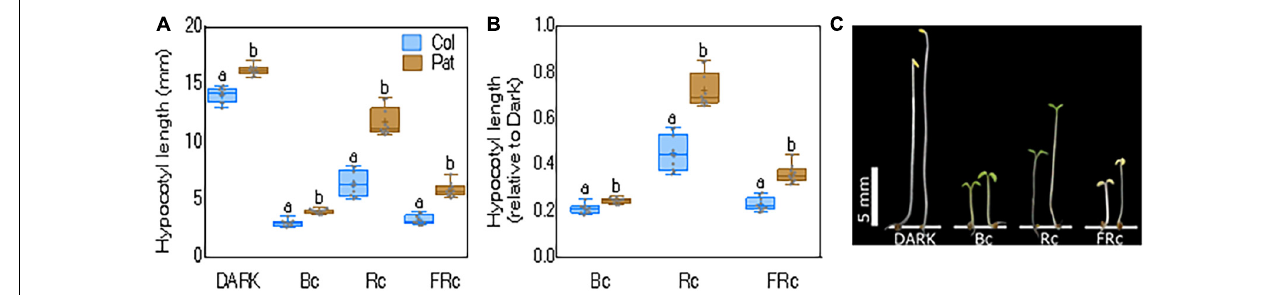
FIGURE 1 | Hypocotyl length for seedling de-etiolation in Col-0 and Pat. Hypocotyl length as (A) absolute or (B) relative to dark for Col-0 and Pat accessions in R, FR, and B continuous light (Rc = 30 µ mol m-2 s-1, FRc = 0.5 µ mol m-2 s-1, and Bc = 1 µ mol m-2 s-1, respectively). Data are shown as means and SE and significant differences between means are indicated with different letters (LSD test, p -value < 0.05). (C) Photo shows representative seedlings in each light